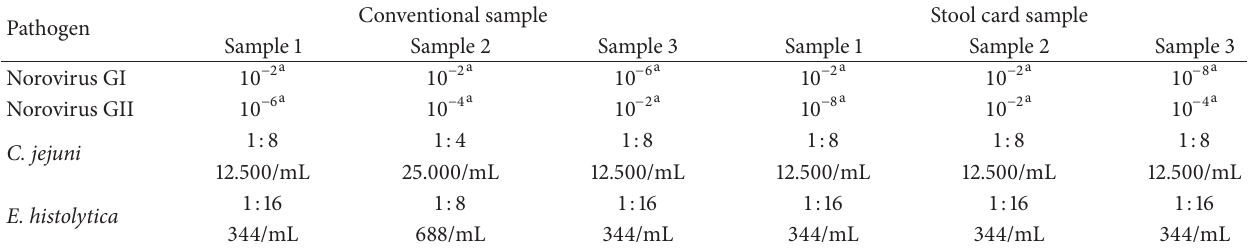
Table 1: LPDs and LPCs of the serial dilutions for norovirus GI/GII, C. jejuni , and E. histolytica native and card samples. Pathogen